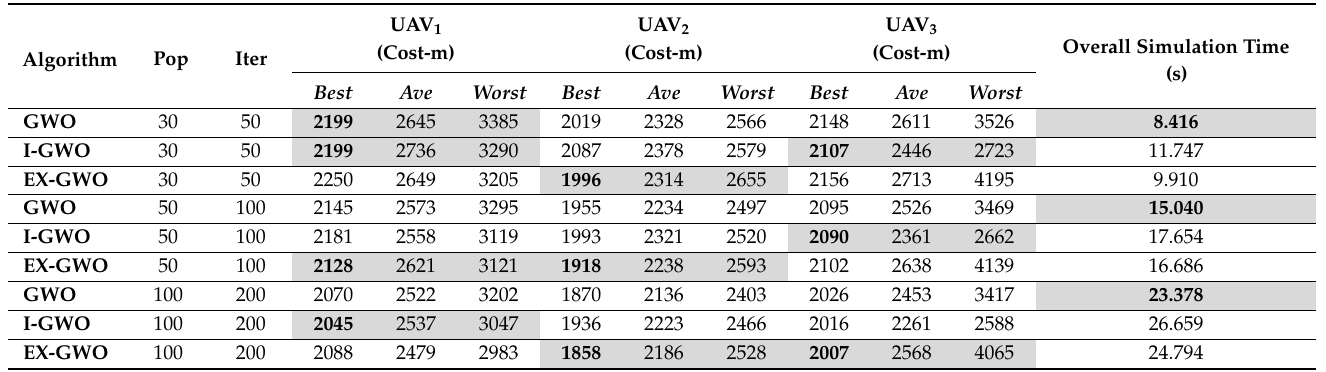
Table 2. Simulation results for each path planning algorithm on crowded large-scale map.